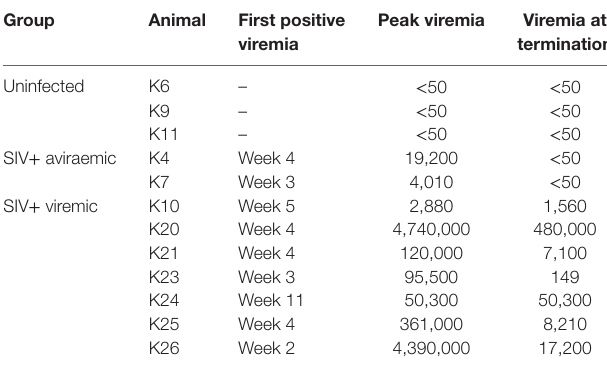
TaBle 1 | Virological information for the animals in the study.